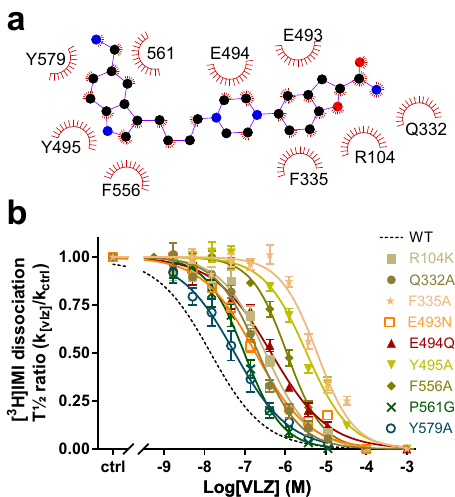
Fig. 6 Effect of SERT S2 mutants on VLZ allosteric potency. a Zoomed interactions between VLZ and SERT. Schematics are generated by LIGPLOT + 1.4. Each eyelash motif indicates a hydrophobic contact. b Effect of mutating residues in the S2 site on allosteric potency for VLZ. Point mutation of residues, shown in the cryo-EM structure to interact with VLZ, all signi fi cantly ( P < 0.001, one-way ANOVA with Tukey ’ s multiple comparisons test) decreases its allosteric potency to various degrees relative to SERT WT (dotted line, data shown in Fig. 2b). See allosteric potencies for SERT WT and mutants in Table 1. Experiments are performed on membrane preparations from COS-7 cells transiently expressing the indicated SERT mutants. Data are shown as means ± S.E. (error bars), n = 3 – 10. Wild-type is shown with a black dotted line. Allosteric site mutants are shown using colored symbols and solid lines de fi ned in the legend. See Table 1 for quantitative data including allosteric potency and n-value for the individual experiments. Source data are provided as a Source Data fi